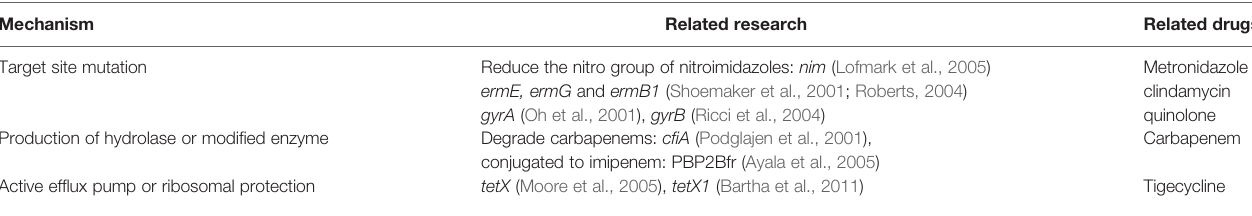
TABLE 2 | The main mechanism of drug resistance in B. fragilis